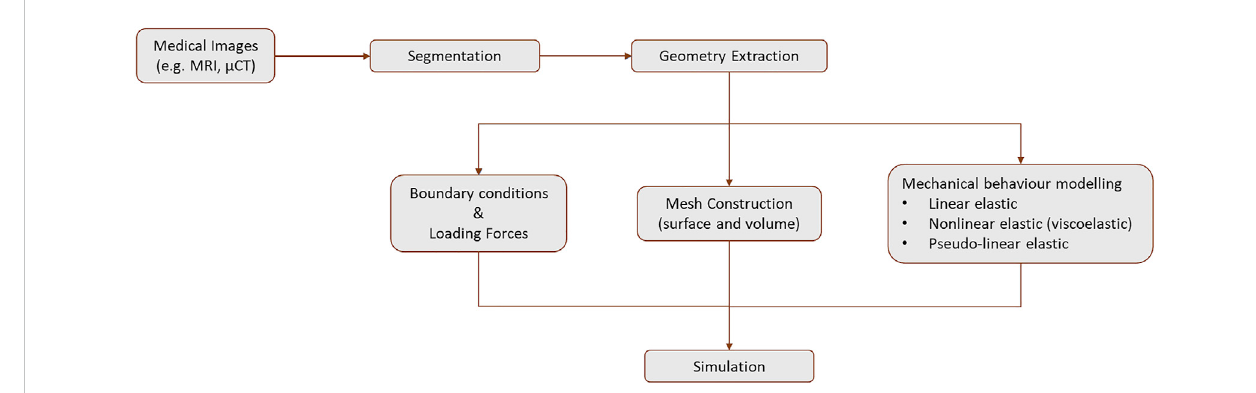
FIGURE 9 Work fl ow of the steps to reach a fi nite element model.